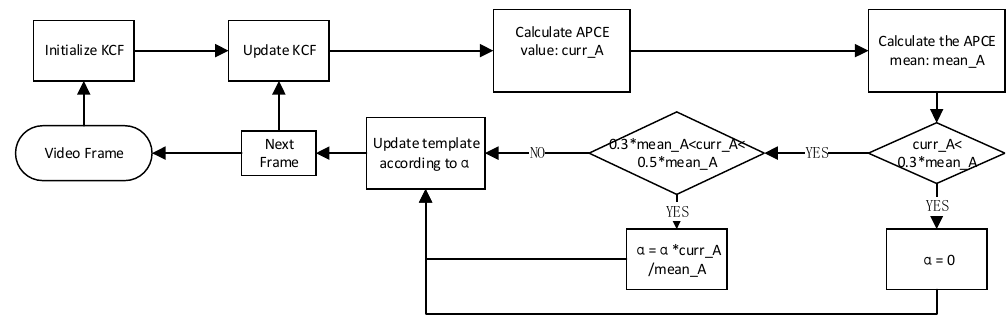
Figure 4. The flow of APCE based high confidence update algorithm.